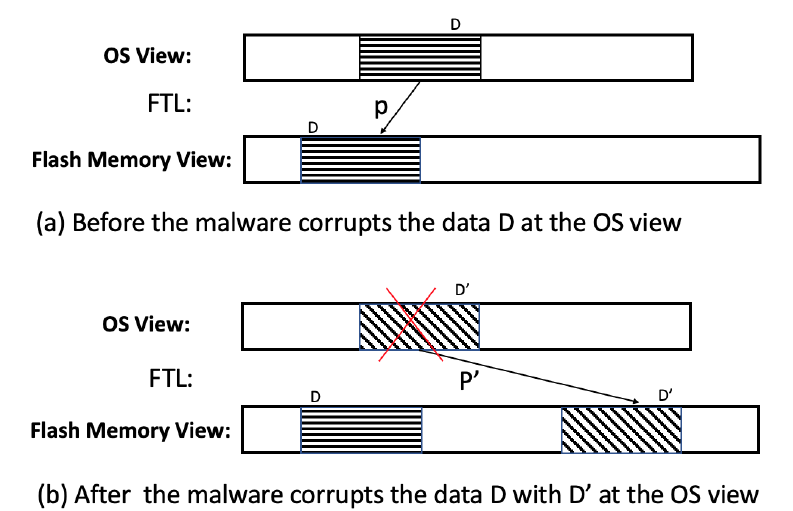
Figure 6. Mappings between the OS view and the flash memory view.